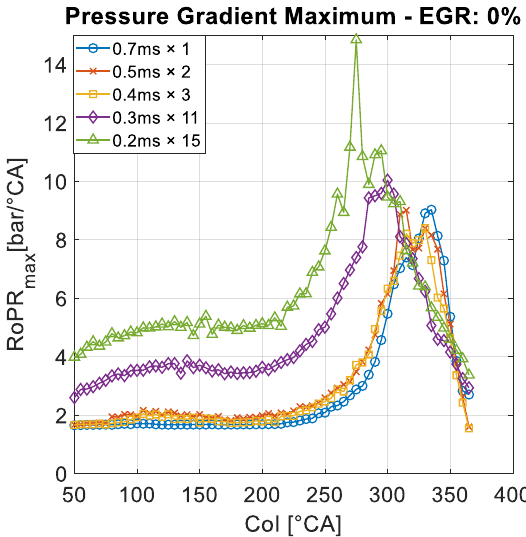
Figure 7. The pressure gradient maxima of the investigated structures with the same dose in the function of CoI without EGR.